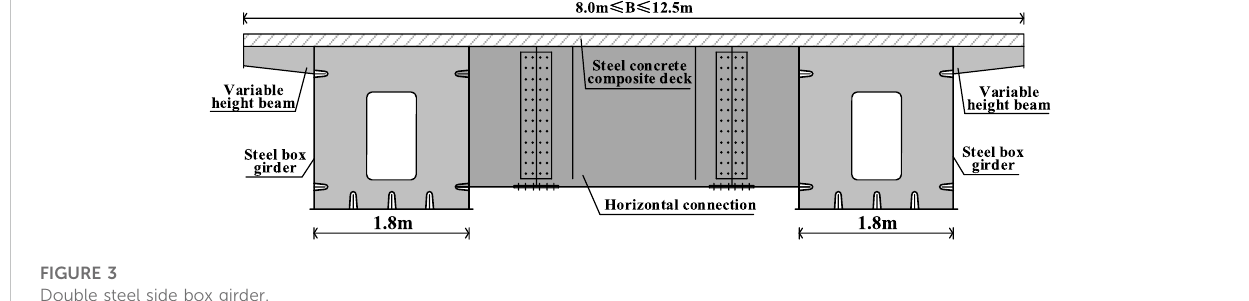
Double steel side box girder.